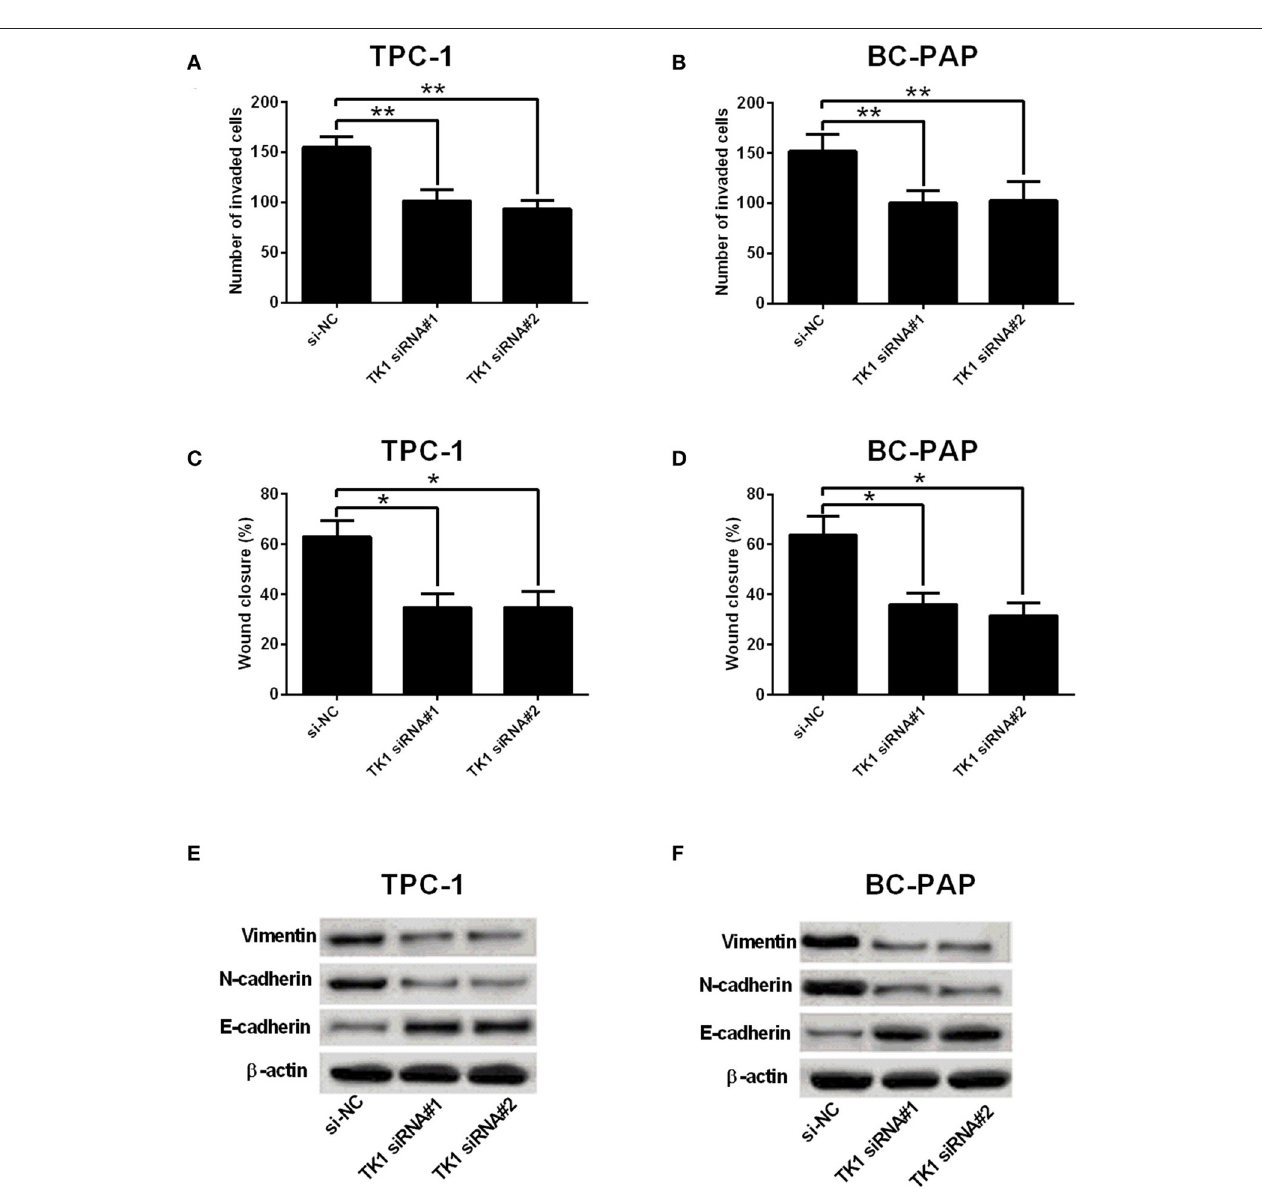
FIGURE 3 | Thymidine kinase 1 (TK1) knockdown suppressed thyroid carcinoma cell invasion, migration, and EMT. (A,B) Transwell invasion assay was used to investigate the invasion ability of TPC-1 and BC-PAP cells transfected with scrambled siRNA (si-NC) or TK1 siRNAs (TK1 siRNA#1 or #2), respectively. (C,D) The migration ability of TPC-1 and BC-PAP cells transfected with scrambled siRNA (si-NC) or TK1 siRNAs (TK1 siRNA#1 or #2) was assessed by wound healing assay, respectively. (E,F) Protein expression levels of epithelial–mesenchymal transition (EMT)-related markers vimentin, N-cadherin, and E-cadherin in TPC-1 and BC-PAP cells transfected with scrambled siRNA (si-NC) or TK1 siRNAs (TK1 siRNA#1 or #2) were detected by Western blot. N = 3; * P < 0.05 and ** P <